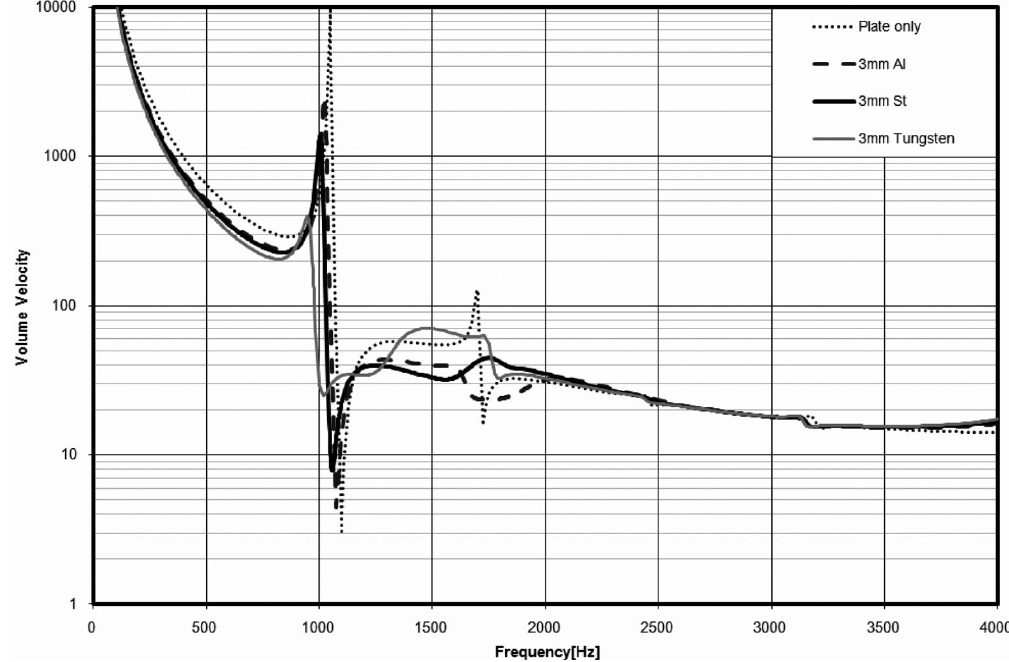
Fig. 56. Frequency response curves for four cases of free-free plate Plate only (dotted), Plate with added Steel ball EIDL (solid black), Plate with added Aluminium ball EIDL (dashed), Plate with added Tungsten ball EIDL (solid grey).